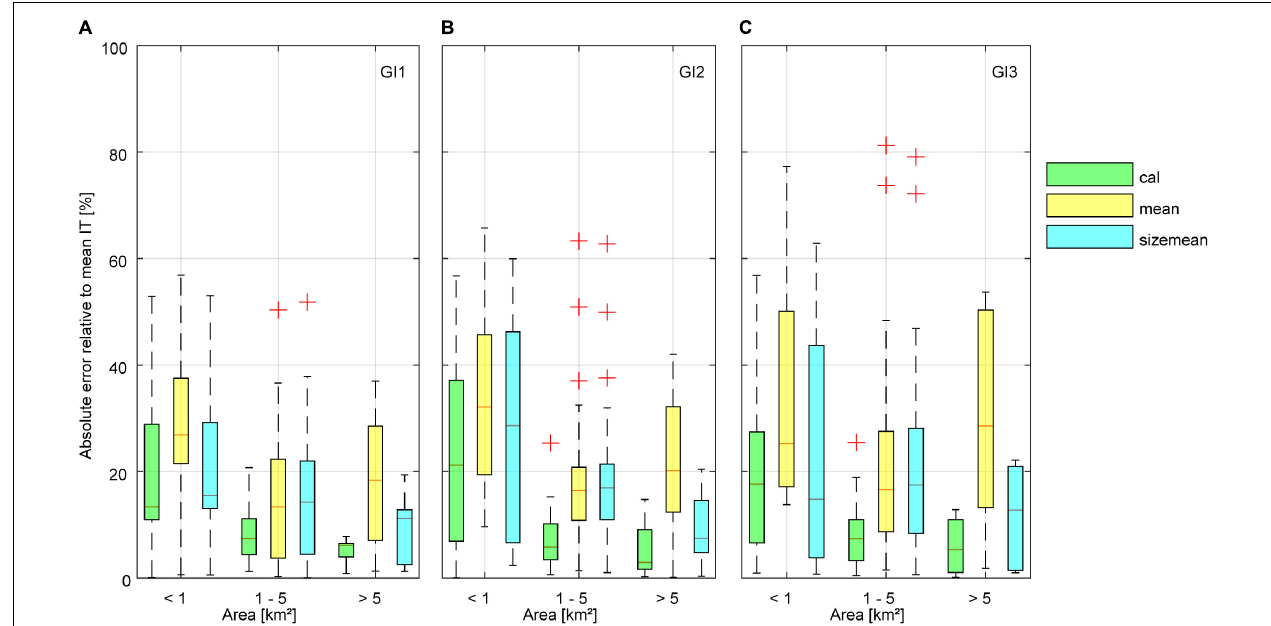
FIGURE 6 | Absolute error between average glacier ice thickness from thickness measurements and modeled glacier mean ice thickness using the calibrated apparent mass balance gradients (cal), overall mean parameters (mean) and parameters for glacier size classes (sizemean) smaller 1 km 2 , 1–5 km 2 and larger than 5 km 2 . Results are shown for all calibration glaciers of the three glacier inventories (A) GI 1, (B) GI 2, and (C) GI 3. The red dash notes the median, and the blue box shows the interquartile range between the 25th and the 75th percentiles. The whiskers encompass all data within 1.5 times the interquartile range. The red crosses present values that are more than 1.5 times the interquartile range away from the top or bottom of the box.